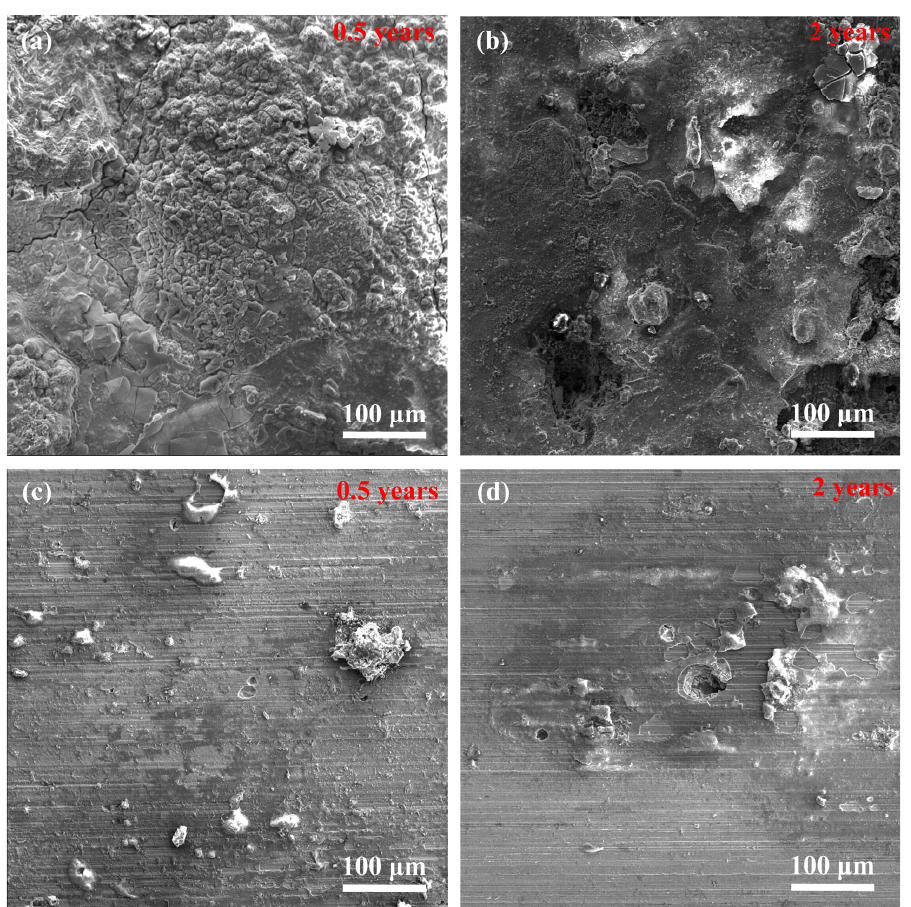
Figure 4. Corrosion microscopic morphology of two stainless steels after field exposure for different times: ( a ) and ( b ) 3Cr13, ( c ) and ( d ) 00Cr12Ni10MoTi.